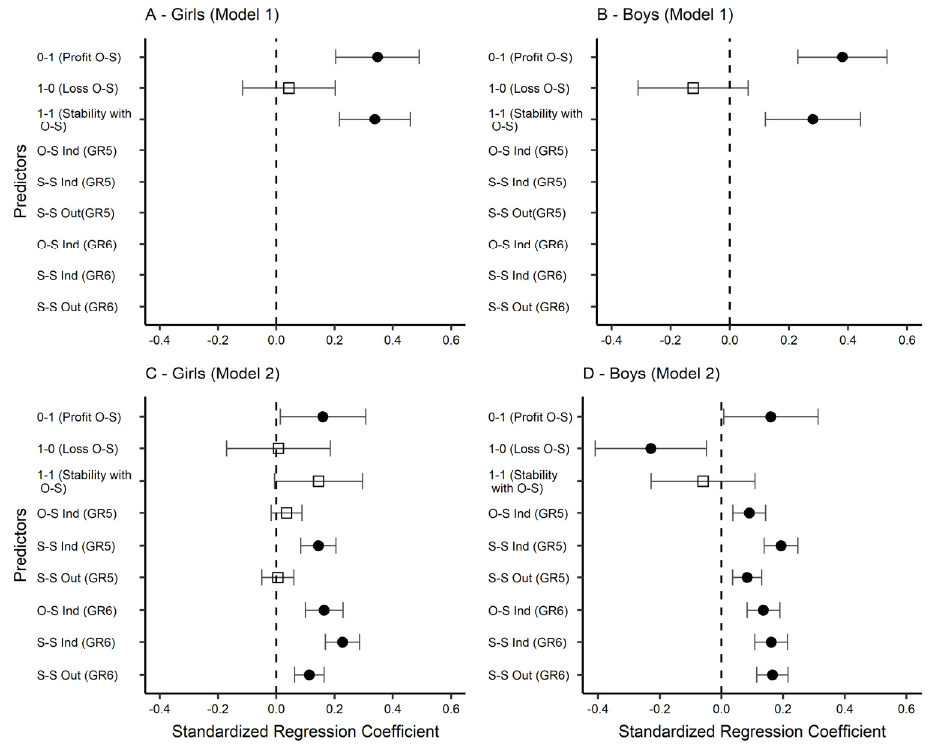
Figure 5. Standardized regression parameters from conditional latent difference score model (LDS) for boys and girls. Note: Black circle—coefficient significant at 0.05; white square—coefficient insignificant ( p > 0.05); tails = standard errors. S-S = same sex; O-S = other sex; Out = out-degree; Ind = in-degree; GR = grade. Stability without O-S is not presented in the model because it serves as the reference category.